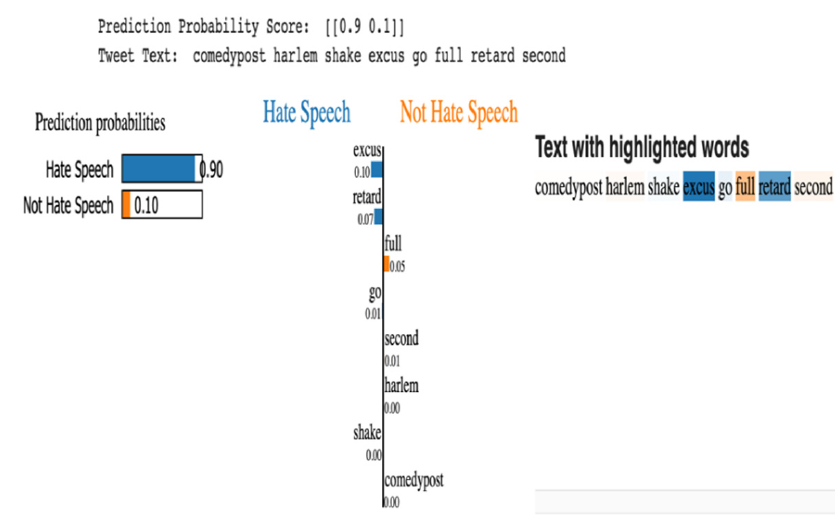
Figure 7. Explainability with random forest.